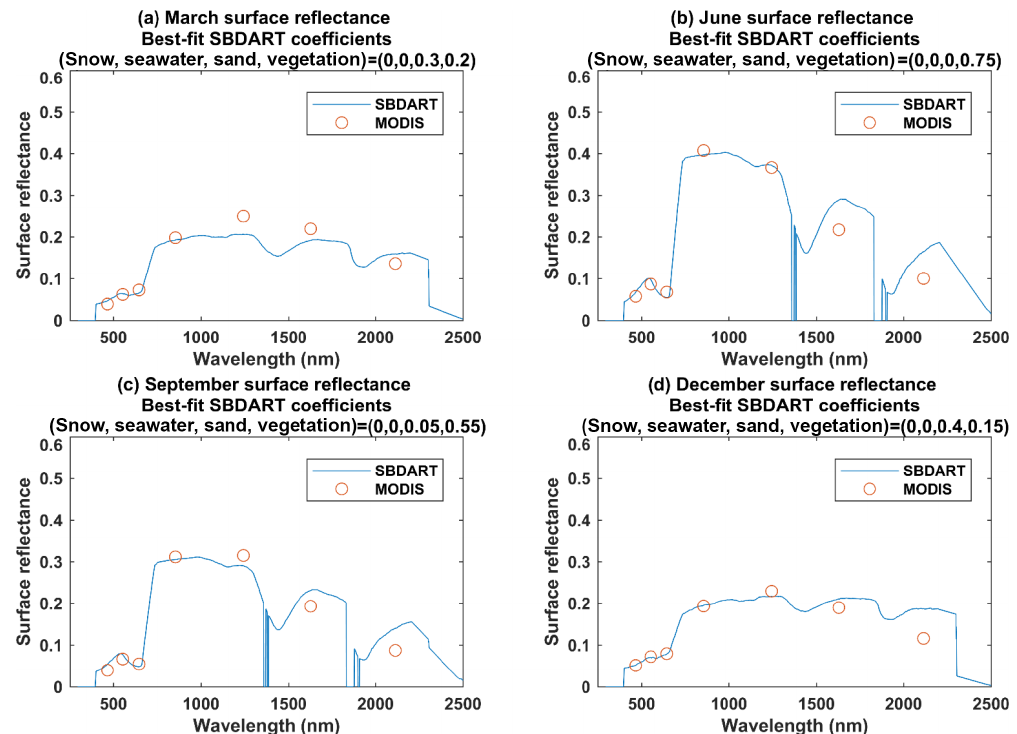
Figure 3. Spectral surface reflectance over the wavelength range 250 to 2500nm for (a) March; (b) June; (c) September; and (d) December. The MODIS values for each month are mean MODIS Aqua spectral surface reflectance values for that month, over the study period. The SBDART curve is based on spectral reflectance produced by the vegetation types whose combination provided best fit with MODIS-measured spectral